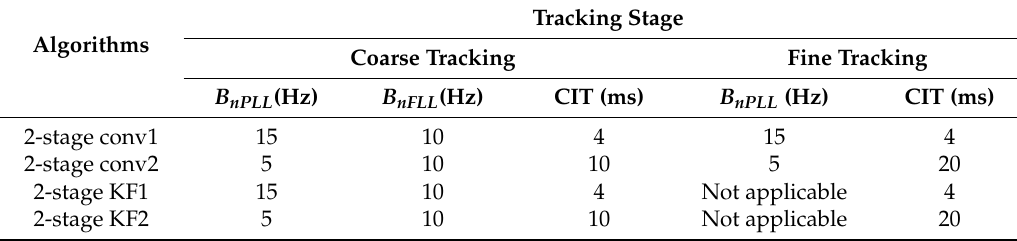
Table 2. Tracking algorithms that are considered in the assessment. Tracking Stage Algorithms Coarse Tracking Fine